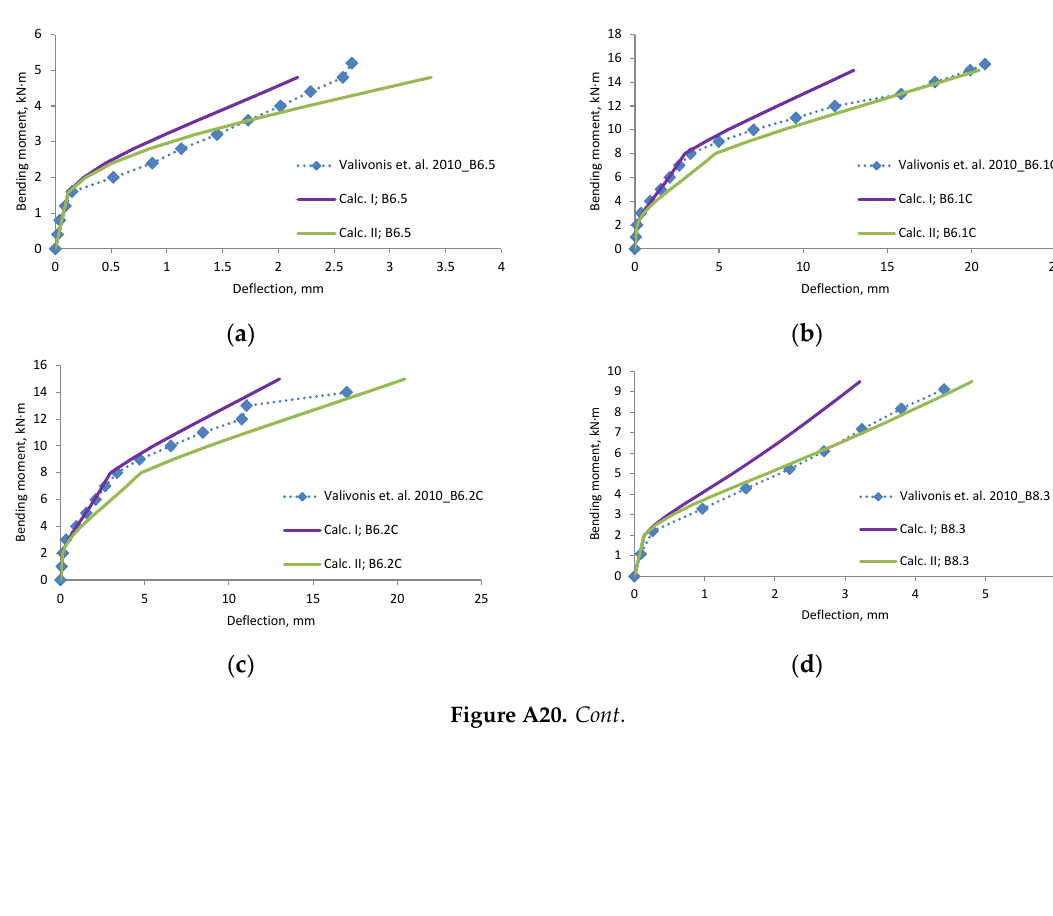
Figure A19. Teng et al., 2006 [42] research beams deflection compared with calculated, ( a ) beam B0; ( b ) beam B500; ( c ) beam B1200; ( d ) beam B1800; ( e ) beam B2900; ( f ) scatter of the results at 60% and 80% of the ultimate load.